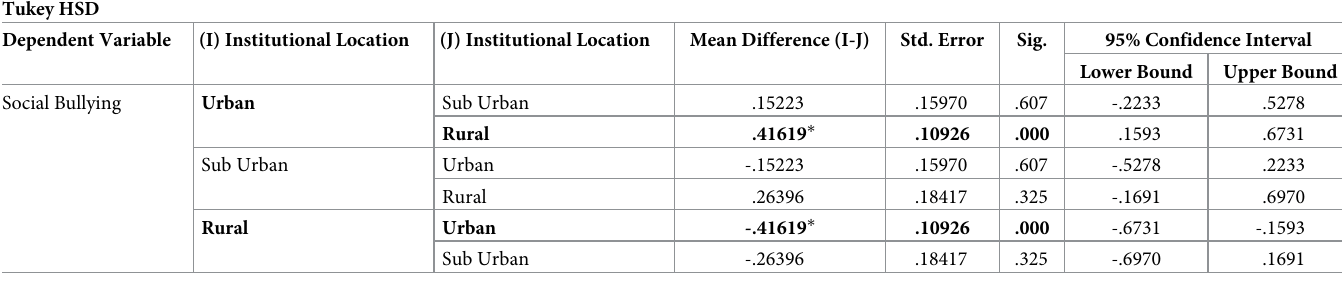
Table 8. Multiple